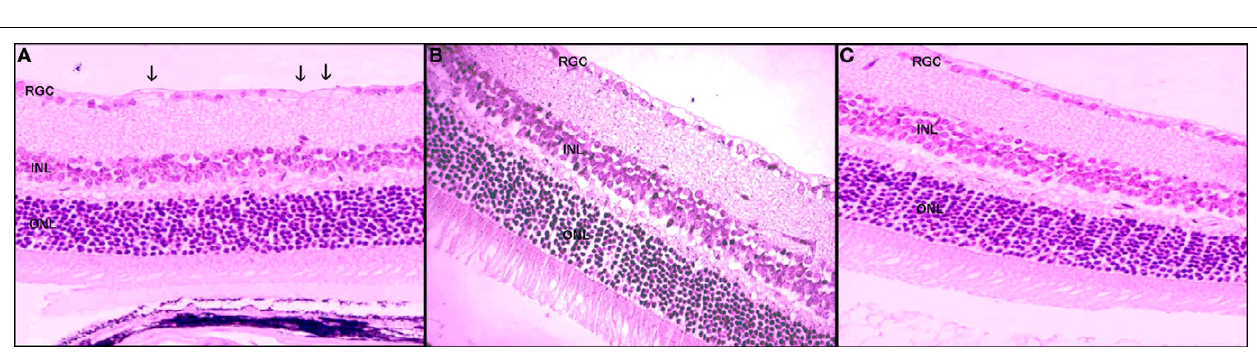
FIGURE 3 | Retinal ganglion cells loss following rAION induction. (A) Untreated eye 21days after rAION induction. Note the RGC loss (arrows). (B) HBO-treated eye. Note the absence of RGC loss ( × 40). (C) Uninjured eye (H&E).